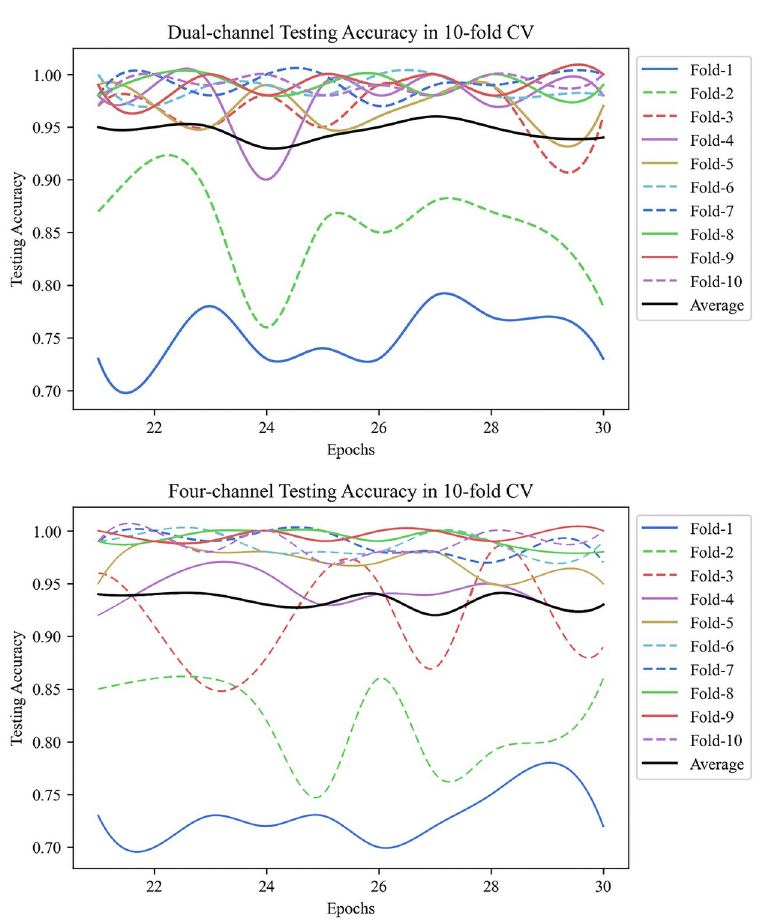
Fig 9. DIDC and four-channel 10-fold cross-validation accuracy results. The average 10-fold scores for each epochs were demonstrated using the black line, and the average testing accuracy for DIDC is 0.95, for four-channel is 0.94.